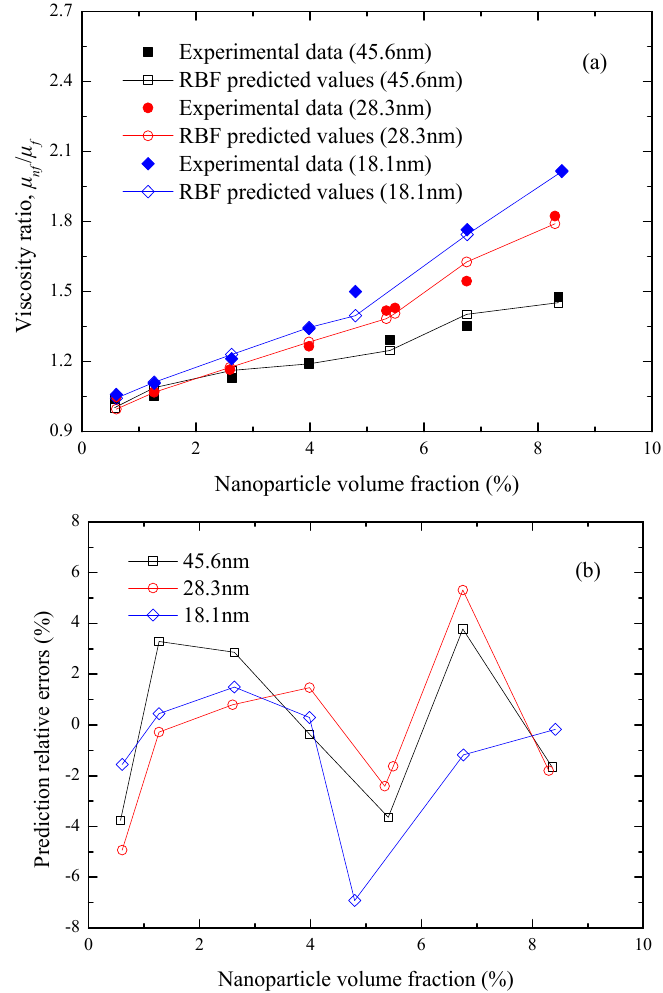
Figure 7. ( a ) Predicted comparisons and ( b ) relative errors of the RBF predicted μ nf / μ f and the experimental data [15] for SiO 2 -ethylene glycol nanofluids at T = 25 °C.